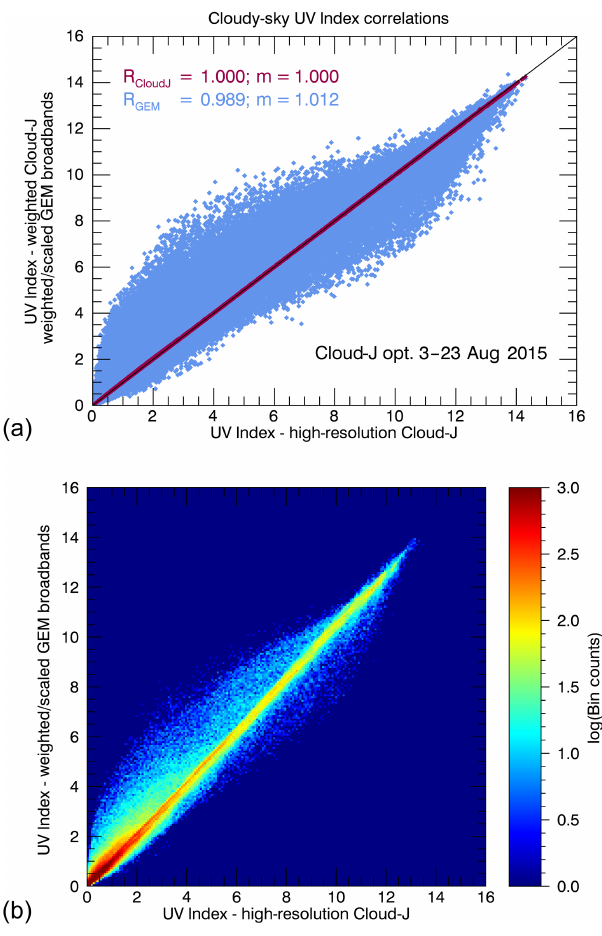
Figure 12. Analogous correlations of the UV Index fields gener- ated from the Cloud-J (purple) and GEM (blue) broadband irradi- ances under cloudy-sky conditions using Cloud-J cloud flag option 3 in the comparison. Panel (a) presents the direct linear correla- tions of the UV Index calculated using the GEM and Cloud-J broad- band irradiances relative to the high-resolution output produced by Cloud-J using the same scaling functions and weighting determined through the integration approach under clear-sky conditions. Panel (b) is a density plot of the correlation of the UV Index calculated us- ing the GEM broadband irradiances compared to the Cloud-J high- resolution UV Index field depicted in the upper